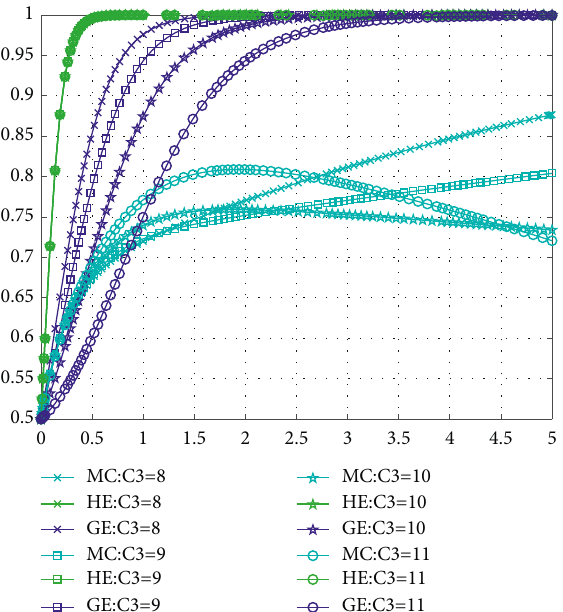
Figure 5: Evolutionary results of changes in independent inno- vation costs of general enterprises.